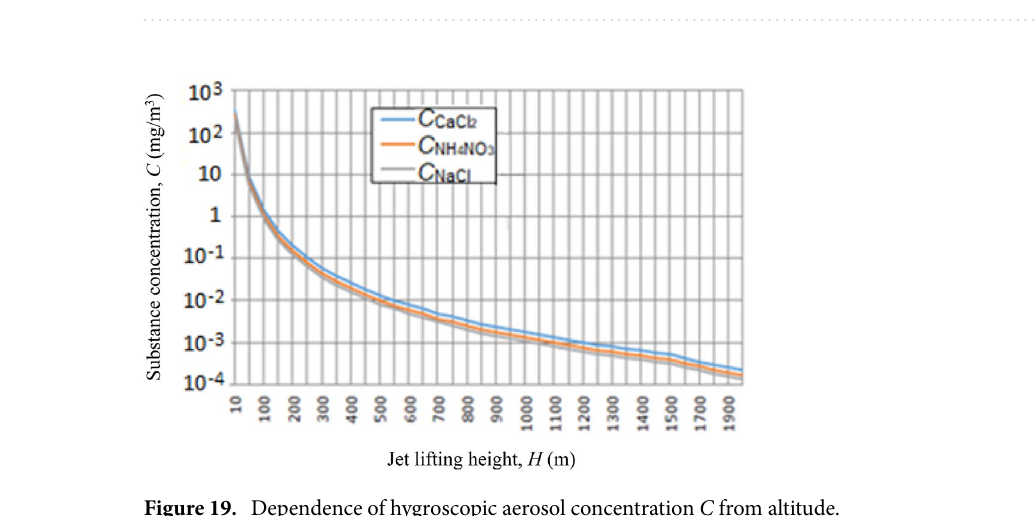
Figure 18. Vertical cross section of artificial updrafts velocity fields W (m/s) at energy recharge values P C = 151 MW, γ = 6.5, 6.5, 8.5 and 9.5 °C/km, vertical wind profile U = 1 + 0.005 H m/s, and f = 70%.